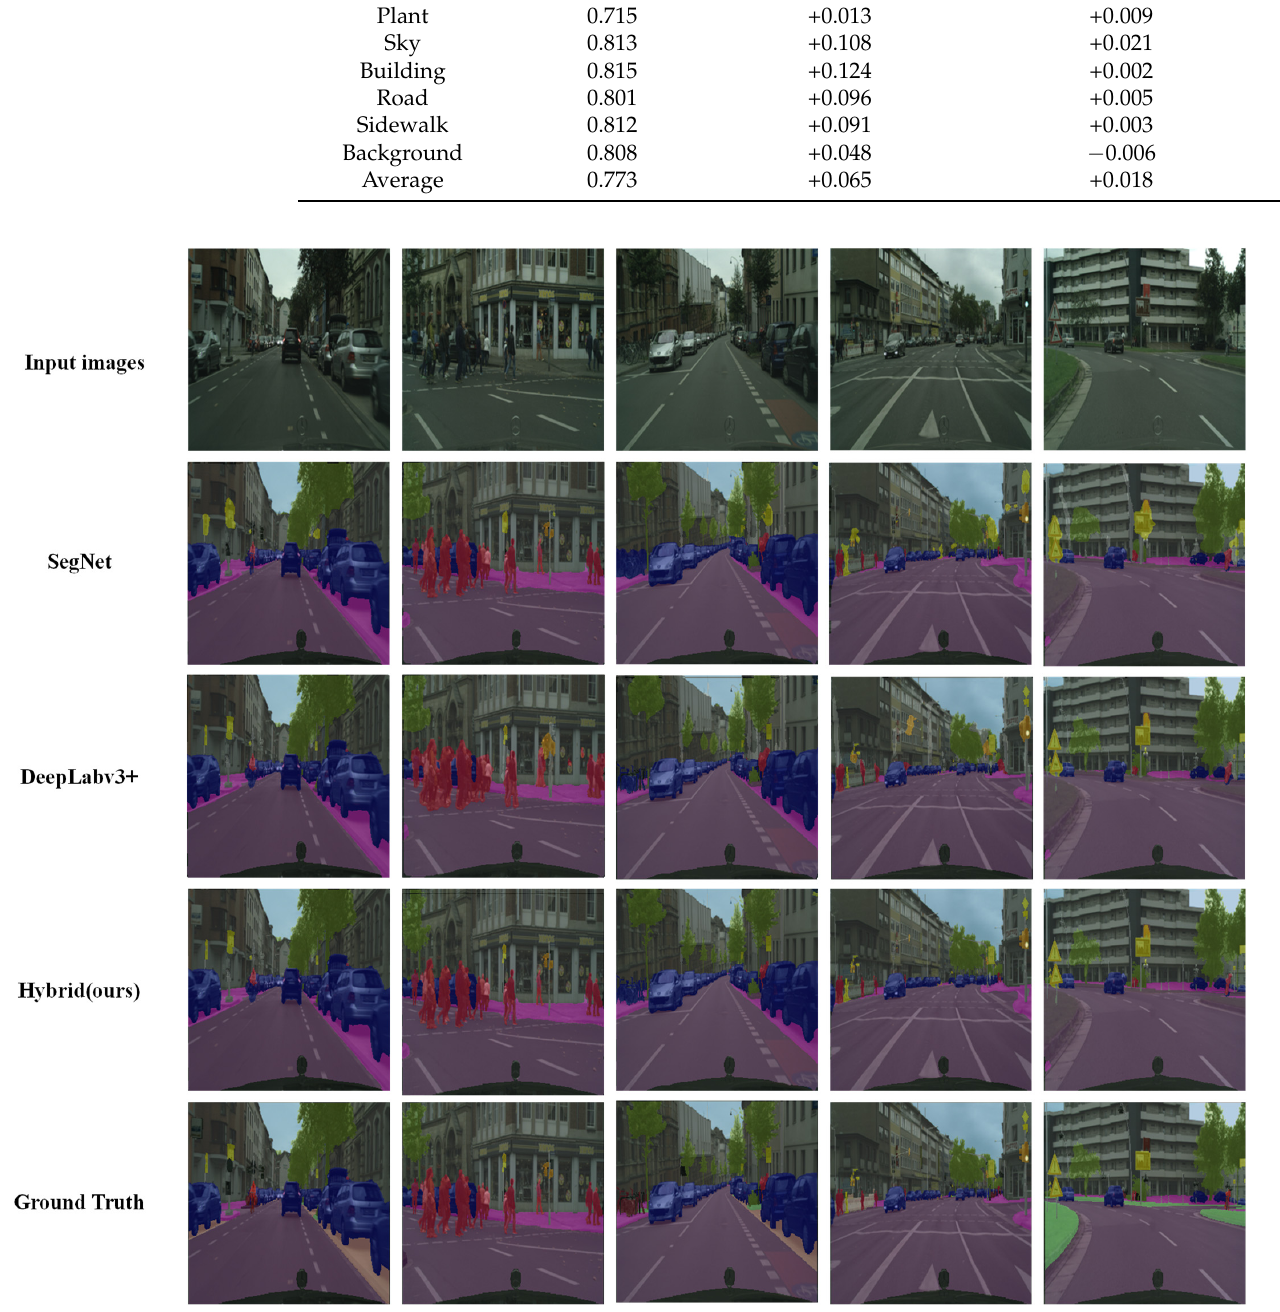
Figure 4. Semantic segmentation for cityscapes